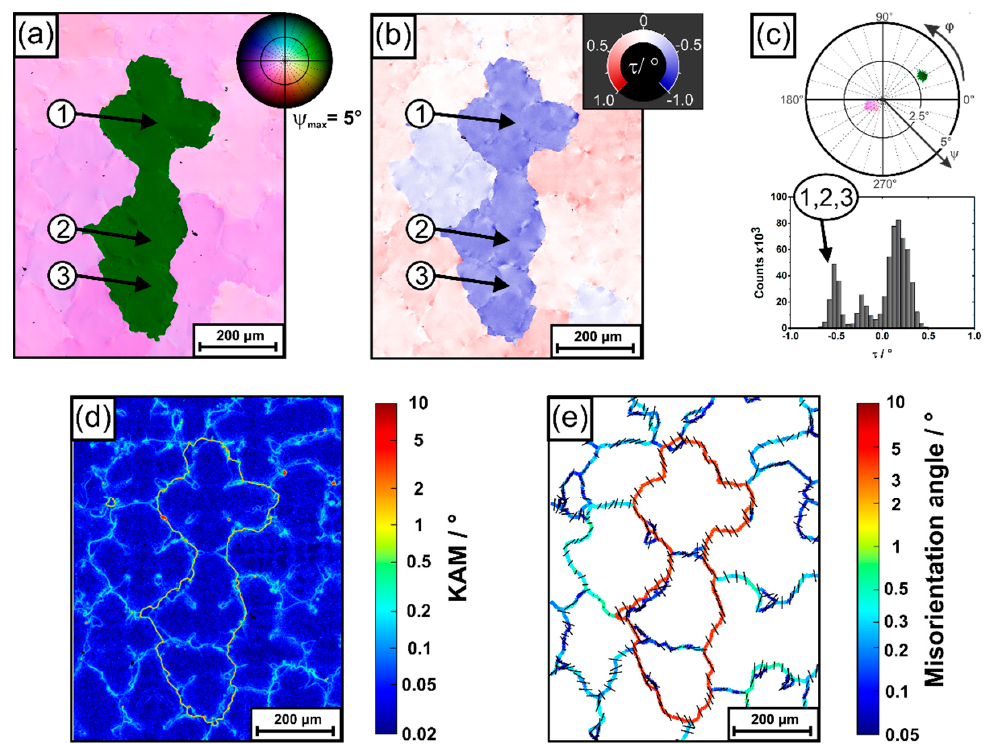
Figure 11. Crystallographic orientations obtained by RVB-EBD from the region considered in Figures 5, 8 and 9. ( a ) Pole figure color coding of <001> directions. ( b ) Rotations around <001> axes. ( c ) Orientation distributions. ( d ) Kernel average misorientation data. ( e ) Misorientations between dendrites characterized through the axis/angle convention. The black bars correspond to projected rotation axes. For details, see text.